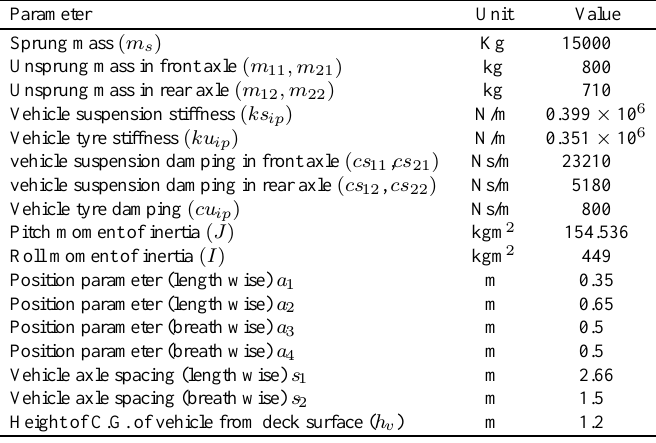
Table 2 Data of vehicle with seven degrees of freedom (Fig. 1)